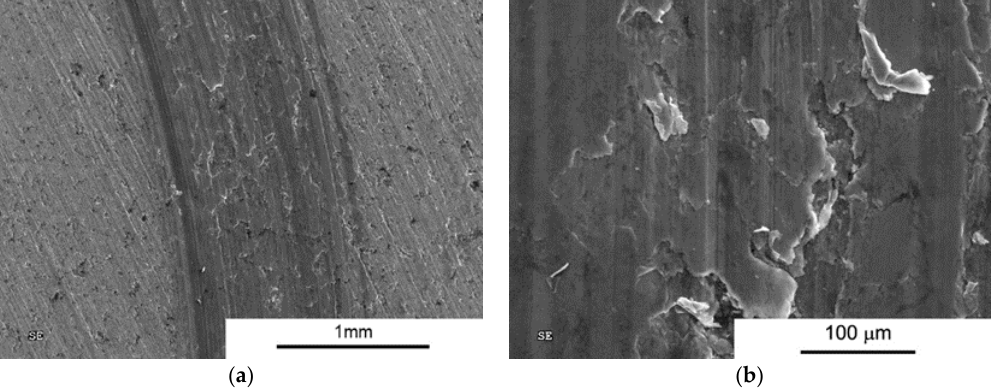
Figure 19. Worn Surface morphology for AA 6061 + 10 vol % MLG—load 10N SPT. ( a ) Wear trace image; and ( b ) close-up view.